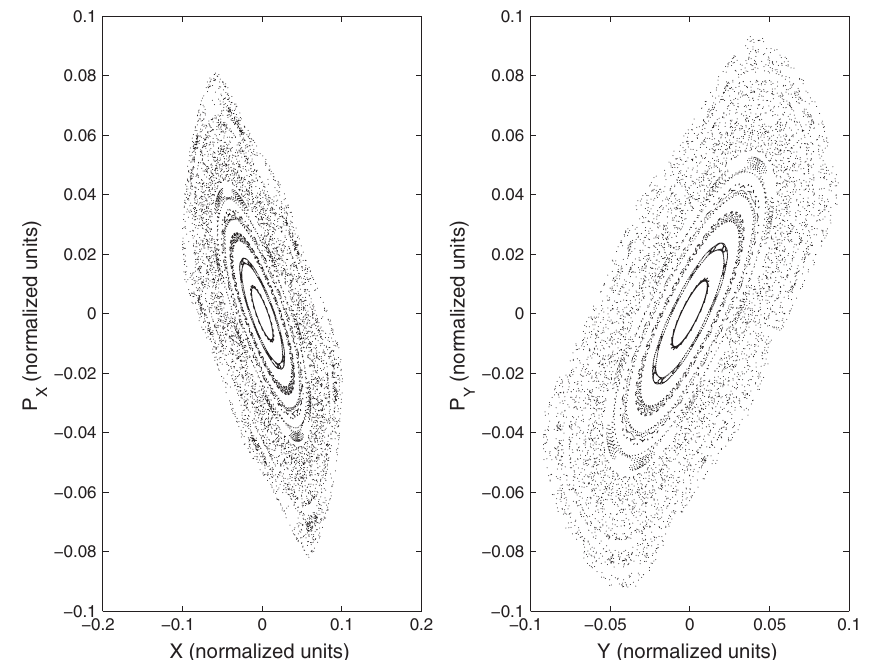
FIG. 5. Octupole phase space for the horizontal (left) and vertical (right) motion for the beta ratios equal to